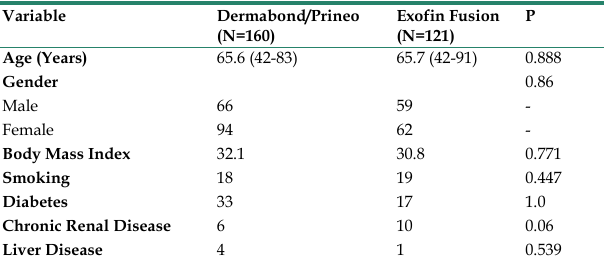
Table 2. Secondary Outcomes: Patient Data and Co-Morbidities